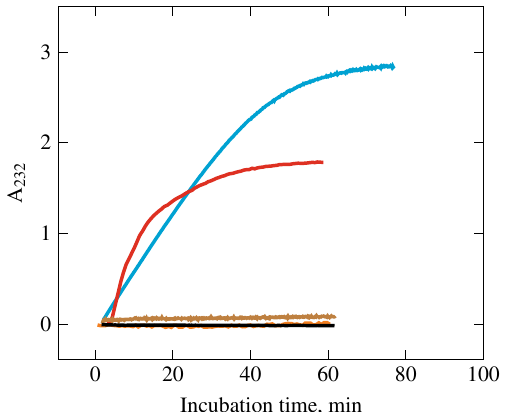
Figure 5. In situ -monitoring of the double bond formation during the β -elimination reaction of HA (2 mg/ml ◦ HA in the phosphate buffer, pH 6, 37 C):